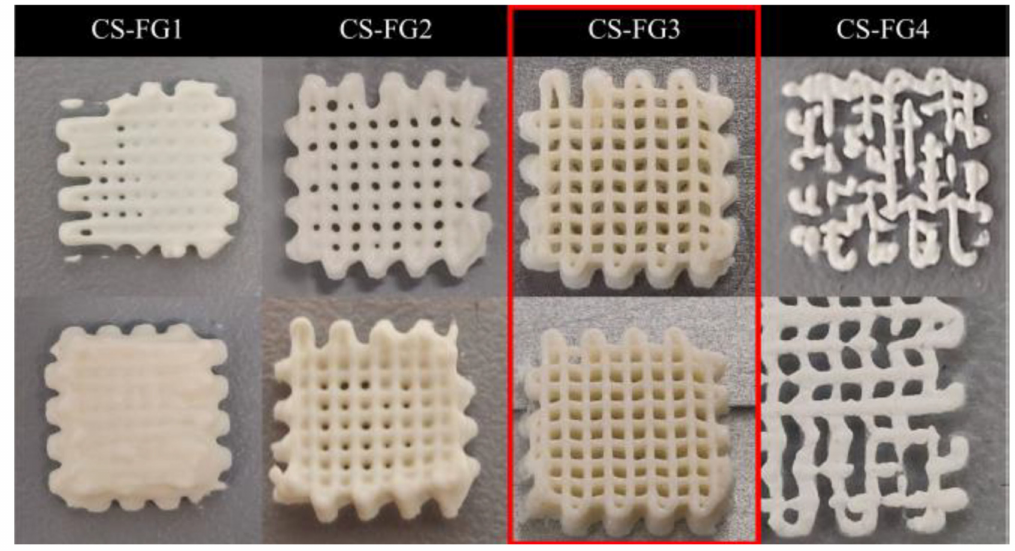
Figure 2. Digital images revealing the obtained structures during the 3D printing trials using the composite precursors based on FG and